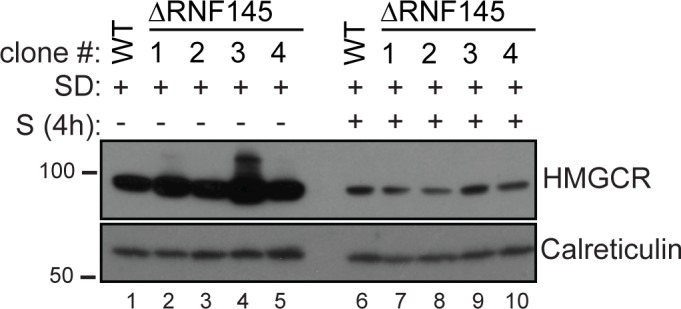
RNF145 loss is insufficient to block sterol-induced HMGCR degradation.Cells were sterol-depleted (SD) overnight before addition of sterols (S, 4 hr). Whole-cell lysates from WT and four RNF145 knockout clones (#1–4) were separated by SDS-PAGE and HMGCR levels visualised by immunoblot analysis. Calreticulin serves as a loading control.